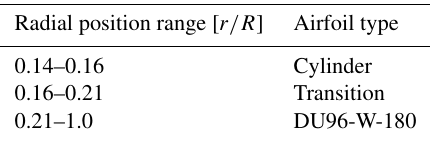
Figure 2. Experimental setup with the chordwise PIV measurement configuration. The coordinate system used in this work is also dis- played. The azimuthal direction θ is opposite to the direction of rotation ω